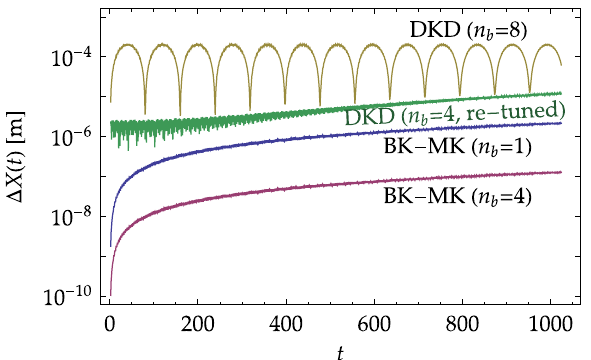
FIG. 6. Evolution of the orbital error in X as a function of turn number t . The four curves correspond to different methods of integration: from top to bottom they are drift-kick with n and no tune fit (tan), drift-kick after tune fitting with n (green), and BK/MK with n For the reference solution, we used BK/MK with n